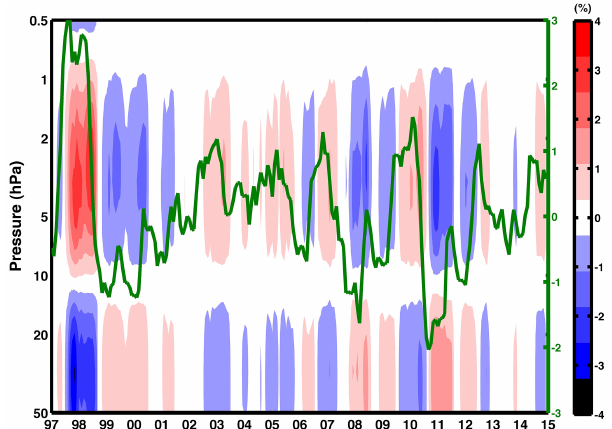
Figure 9. Amplitude of the ozone-ENSO fitted during multilinear regression for the time interval from January 1997 to January 2015. The green line represents the MEI